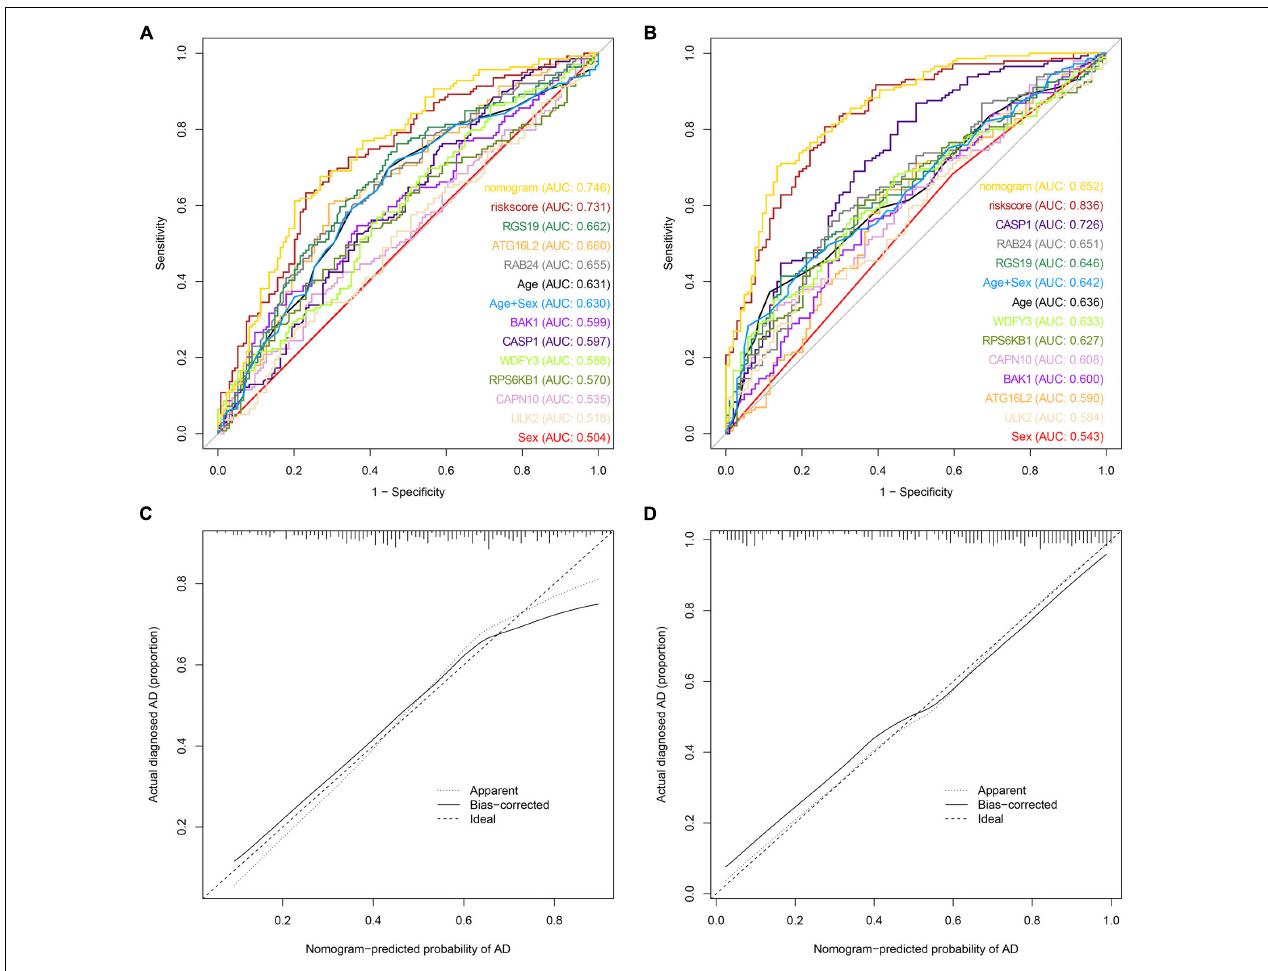
FIGURE 4 | Model discrimination and calibration curve analysis. (A) ROC curve for the prognostic model of AD based on GSE63061. (B) ROC curve of the AD prognostic model based on GSE63060. (C) Calibration curve of the AD nomogram prediction in the GSE63061 set. (D) Calibration curve of the AD nomogram prediction in the GSE63060